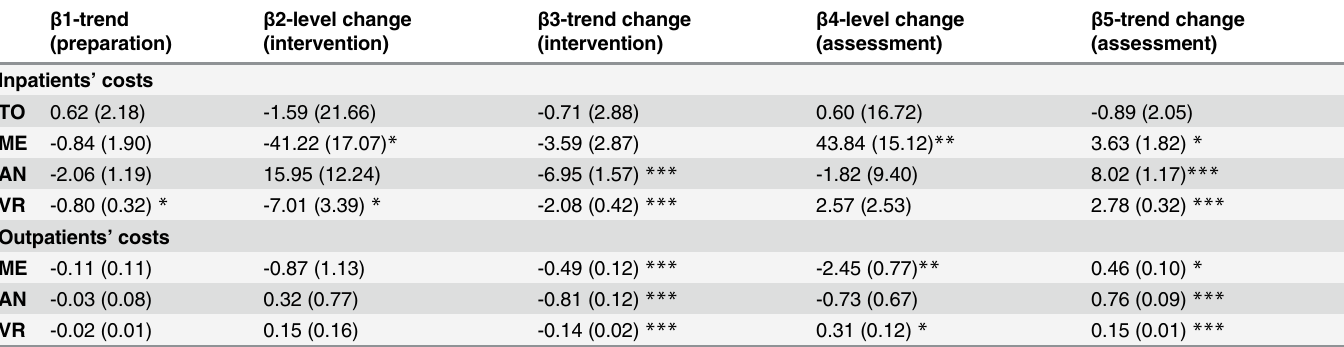
Table 2. Regression analyses of ITS on the changes in patients ’ costs.